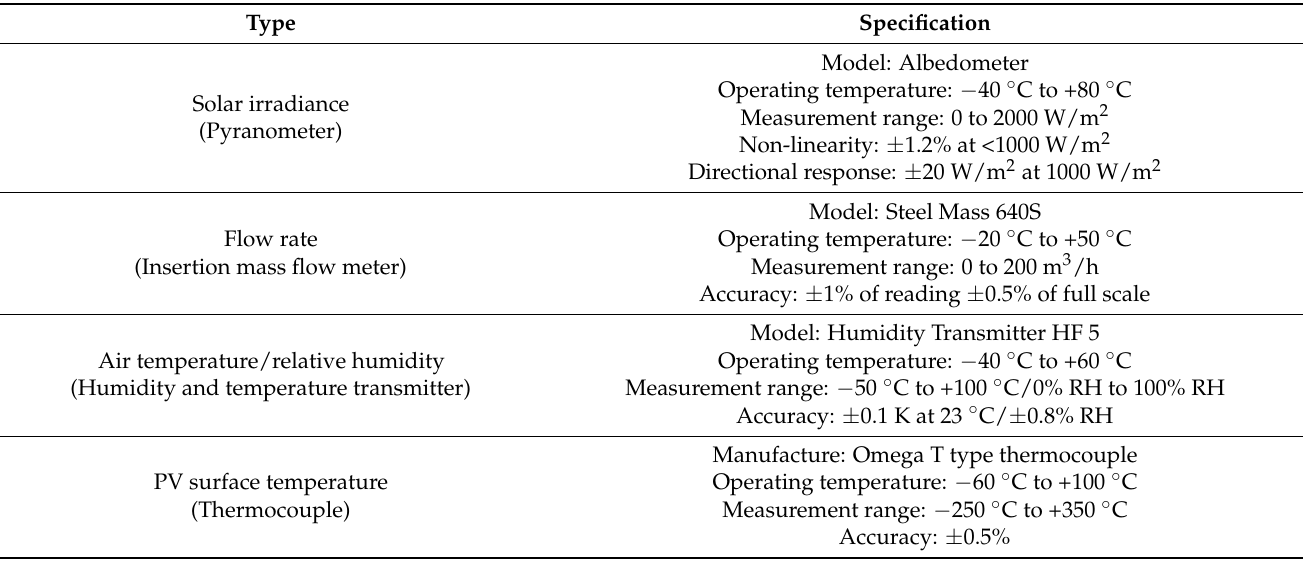
Figure 4. Scheme for Experiment of air-type PVT collector. Table 2. Specifications of the measuring equipment.